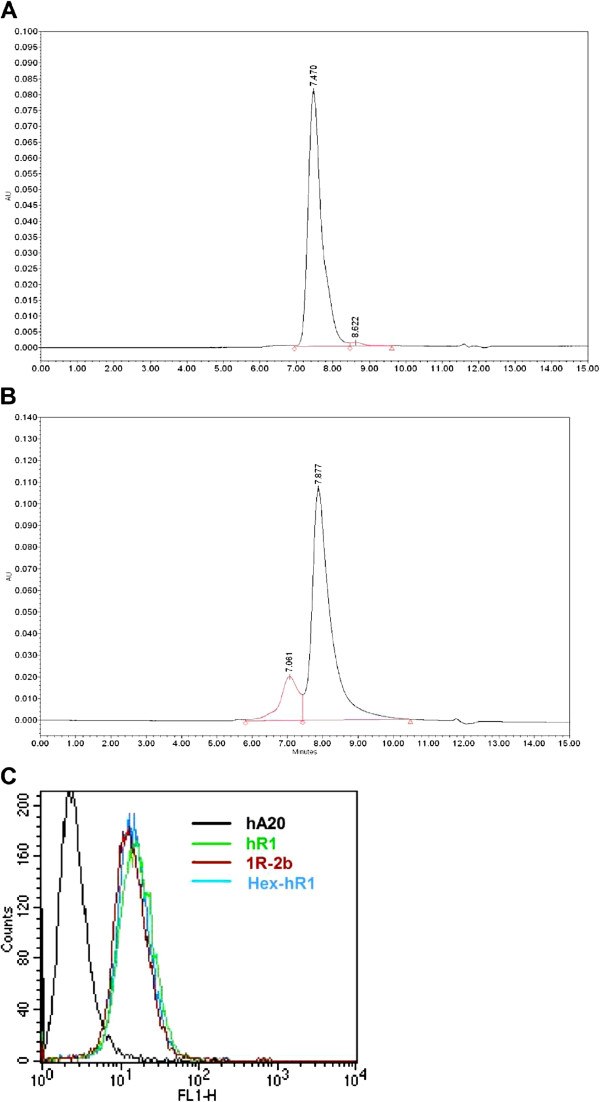
Characterization of Hex-hR1 and 1R-2b. A 50-μg sample of (A) Hex-hR1 or (B) 1R-2b was run on SE-HPLC as described in Materials and Methods. Histograms show UV absorbance of eluted material versus time. (C) Cell binding of hR1, Hex-hR1, and 1R-2b at equimolar concentrations on ACHN cells by FACS staining. Anti-CD20 antibody, hA20, served as negative control.